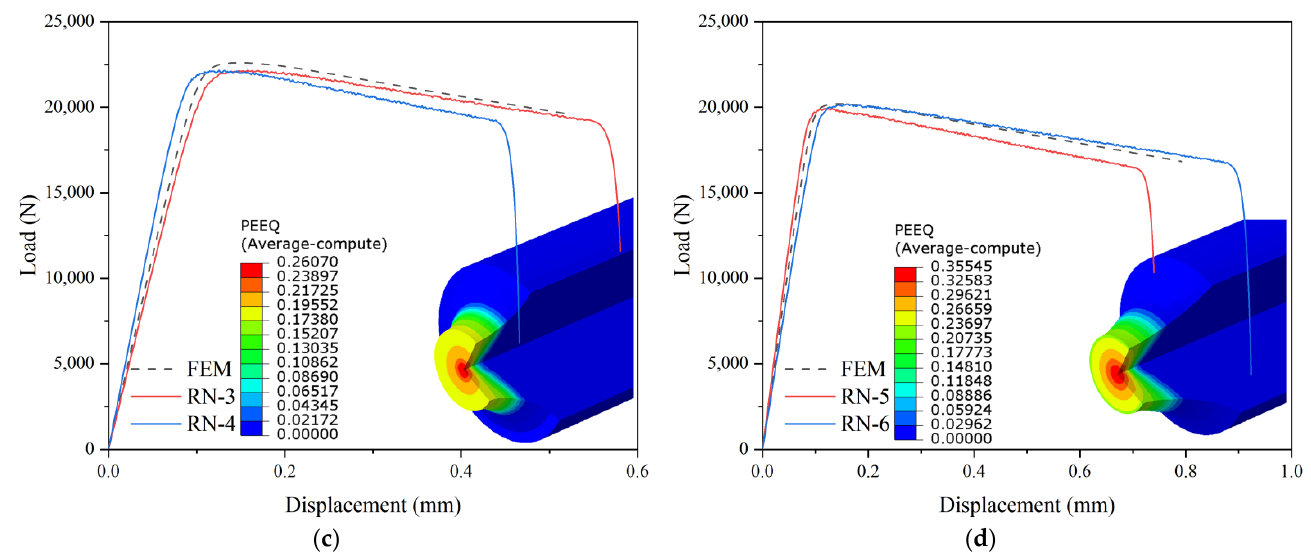
Figure 10. Contrast of load–displacement behavior between the tensile test and the finite element mothod for the smooth and notched round bar: ( a ) smooth round bar (RS-1, 2, 3), ( b ) RN-1 and RN-2 (notch radius = 1.5 mm), ( c ) RN-3 and RN-4 (notch radius = 3.125 mm), ( d ) RN-5 and RN-6 (notch radius = 6.25 mm).